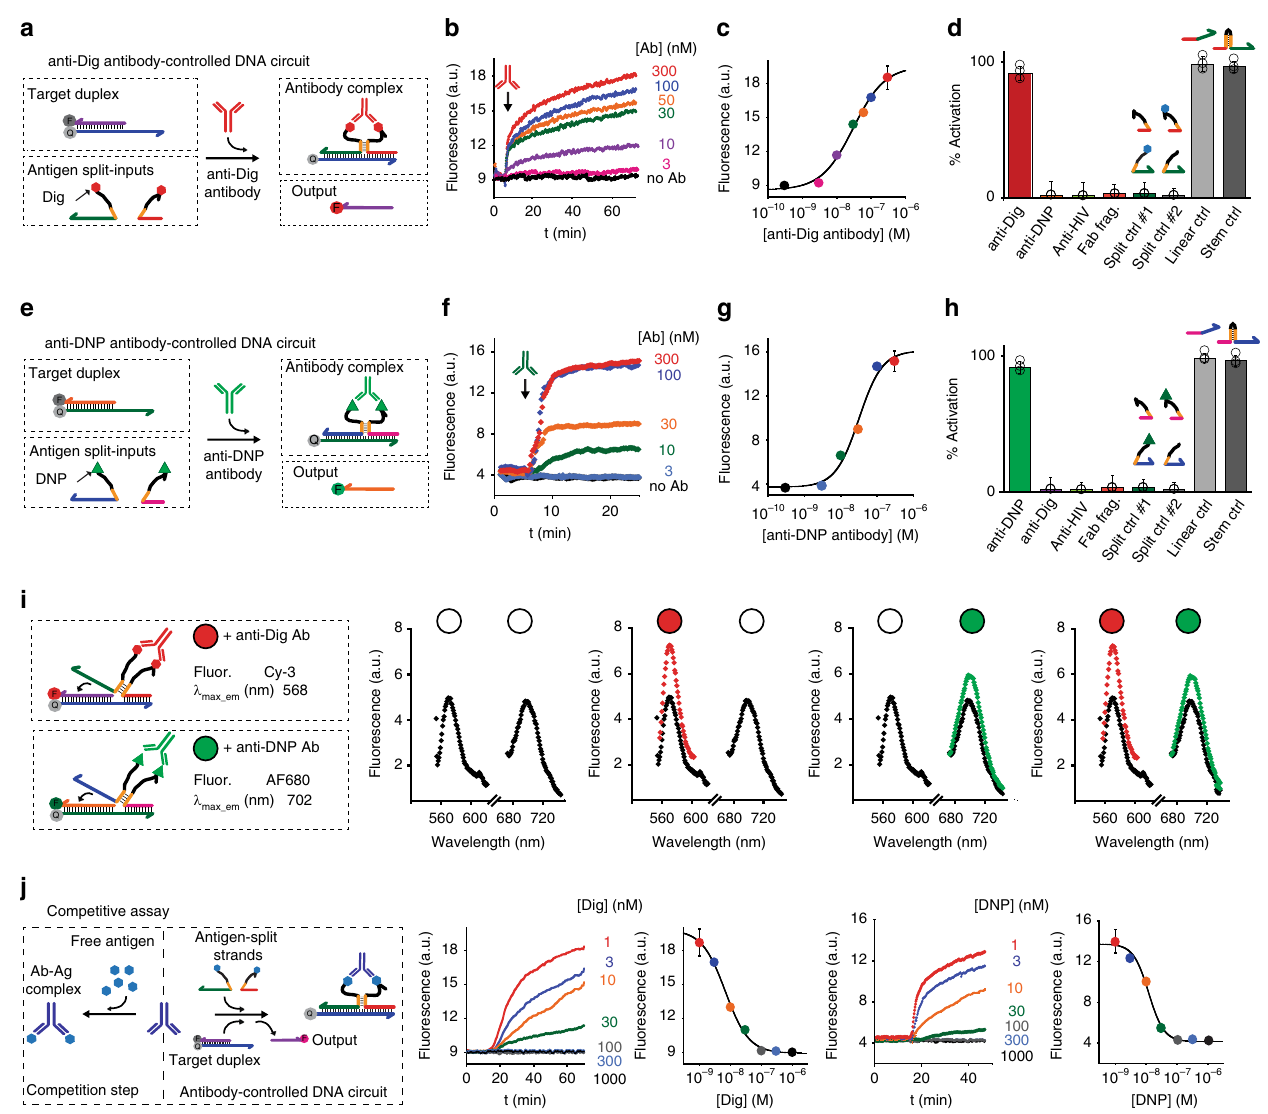
Fig. 2 Designing orthogonal antibody-controlled DNA circuits. a As a fi rst proof-of-principle of our strategy we used digoxigenin (Dig) as antigen and anti- Dig antibodies as molecular triggers of our strand displacement reaction. b Kinetic traces of strand displacement reaction at different concentrations of anti-Dig antibody. c End point values plotted vs. anti-Dig concentrations. d The reaction is highly speci fi c and is only observed with the speci fi c anti-Dig antibody. Control experiments using only a single split-input conjugated with Digoxigenin show no activation of the reaction (split ctrl. #1 and split ctrl. #2). The signal observed at saturating concentration of antibody (300 nM) is indistinguishable within error from the signal obtained with a fully linear input strand and with a unimolecular input strand containing a 6-nt stem separating the toehold-binding and invading domains. e – h Comparable ef fi ciency and speci fi city can be observed using a different circuit with the two split-inputs labeled with DNP at the two ends and thus triggered by anti-DNP antibodies. i Orthogonal control of two antibody-controlled circuits. The two pairs of antigen-conjugated split-inputs (both at 60 nM) and the two target duplexes (both at 30 nM) are mixed in the same solution. Filled circles identify the added antibody (red = anti-Dig; green = anti-DNP). j Competition assays to detect free antigens (Dig, DNP). The experiments shown in this fi gure were performed in 50 mM Na 2 HPO 4 , 150 mM NaCl at pH 7.0, 25 °C. Strand displacement reactions were carried out in the presence of the target duplex (30 nM) and an equimolar concentration of the antigen-conjugated input- strands (60 nM). For the competition step the split-input strands were incubated in a solution containing different concentrations of the free antigen and a fi xed concentration of the speci fi c antibody (300 nM). The experimental values represent averages of three separate measurements and the error bars re fl ect the standard deviations. For a matter of clarity in the binding curves error bars have been depicted for only one point on each curve and represent the maximum value of standard stem formation is observed at a concentration of 100 nM of the input-strands with a 6-nt stem and studied the strand displace- fl uorophore-conjugated split strand (Fig. 1f). As expected, the ment reaction at increasing concentration of the anti-Dig presence of the anti-Dig antibody leads to a signi fi cant antibody. improvement of the binding af fi nity between the two stem anti-Dig antibody can ef fi ciently induce strand-displacement portions ( K d = 40 ± 10 nM) once more supporting the co- reaction in a concentration-dependent fashion (Fig. 2a). The localization effect induced by antibody binding. In our next overall ef fi ciency increases with anti-Dig antibody concentration experiments we have thus employed the two Dig-conjugated split until it saturates at about 100 nM concentration. Under the